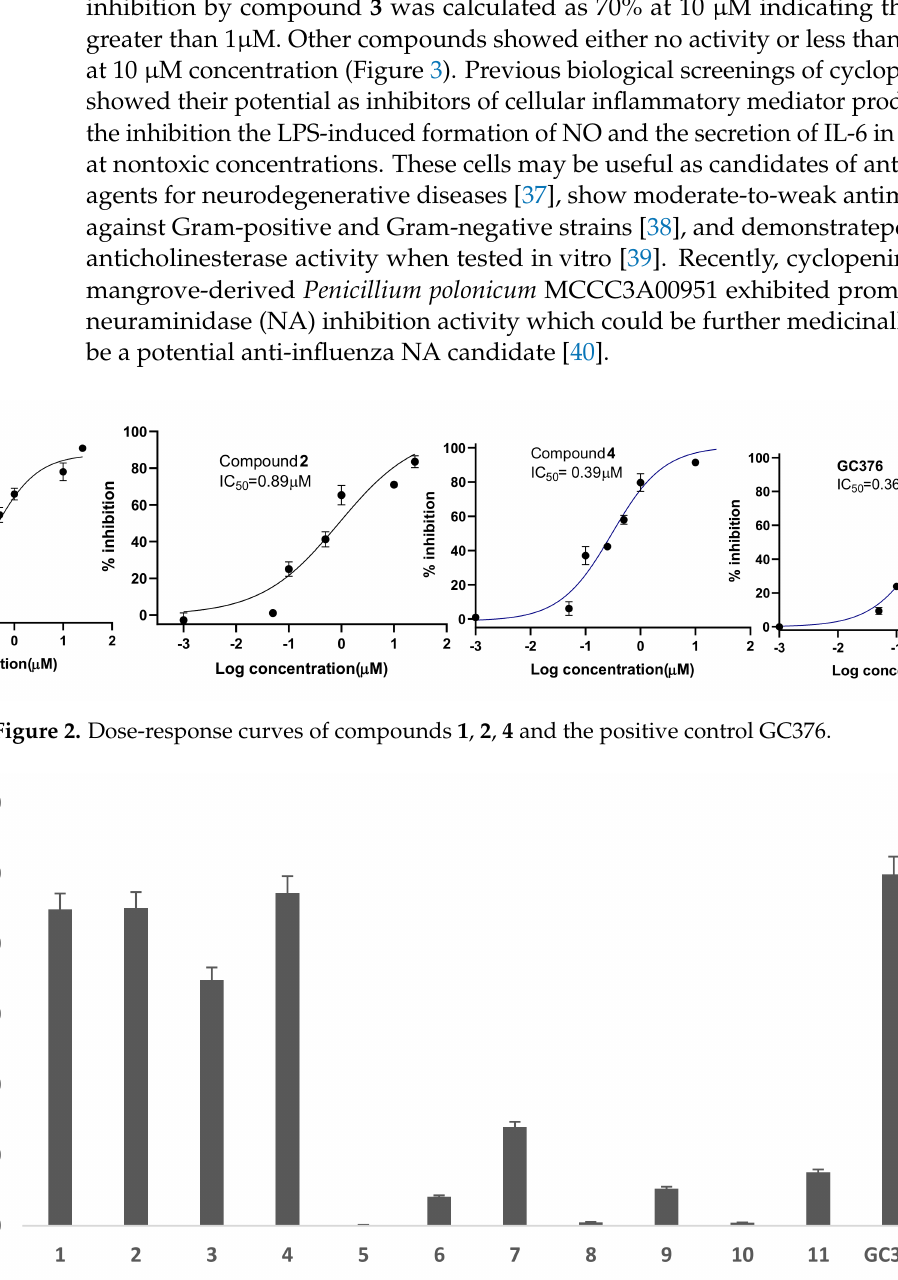
Figure 3. Percentage inhibition of compound 1 – 11 and the positive control GC376 at 10 µ